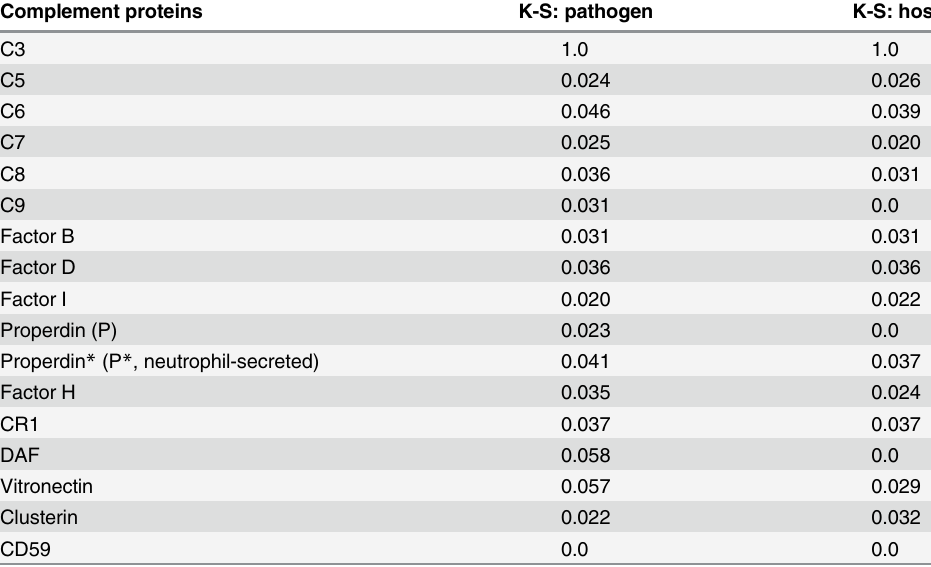
Table 1. Results of multi-parametric sensitivity analysis to initial complement concentrations. In both pathogens and host cells, C3 strongly influenced the model output. Large values of K-S (Kolmogorov-Smir- nov) test indicate that the model output is sensitive to the given parameter